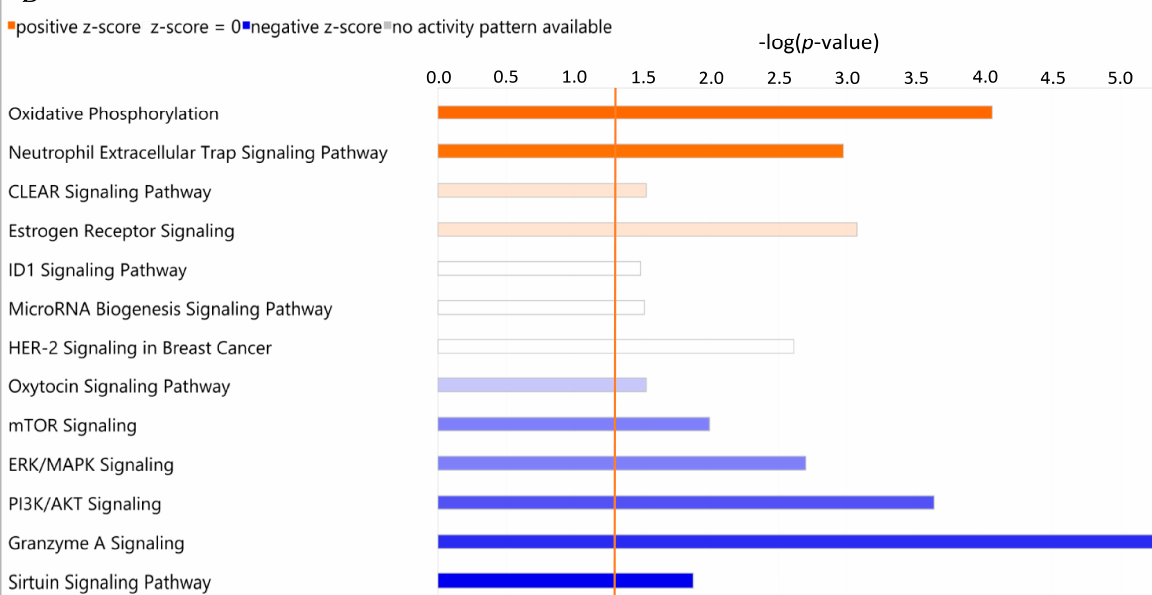
Figure 4. Pathway enrichment analyses of divergent proteomic profiles in CD4 − PBMC of GHR - KO/WT pigs. ( A ) Pathway enrichment analysis using ShinyGO software showing the 10 pathways